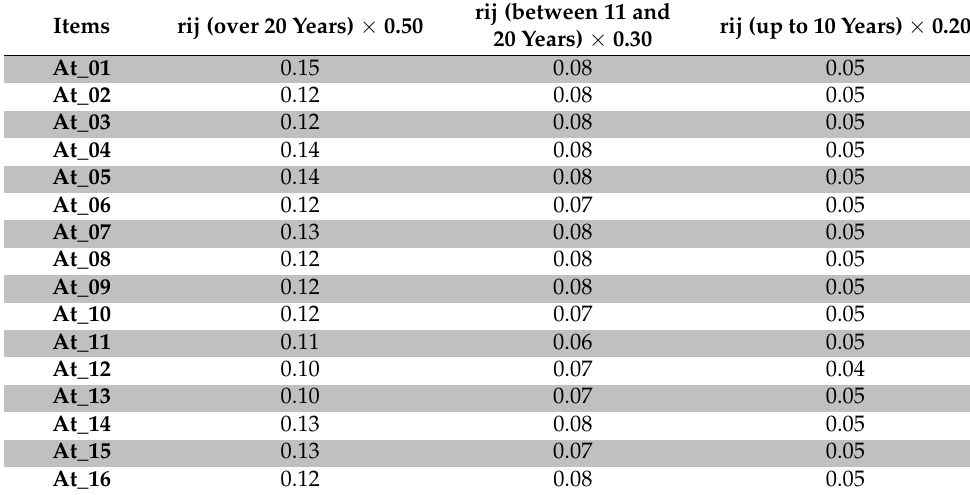
Table 7. Matrix V weighted values.